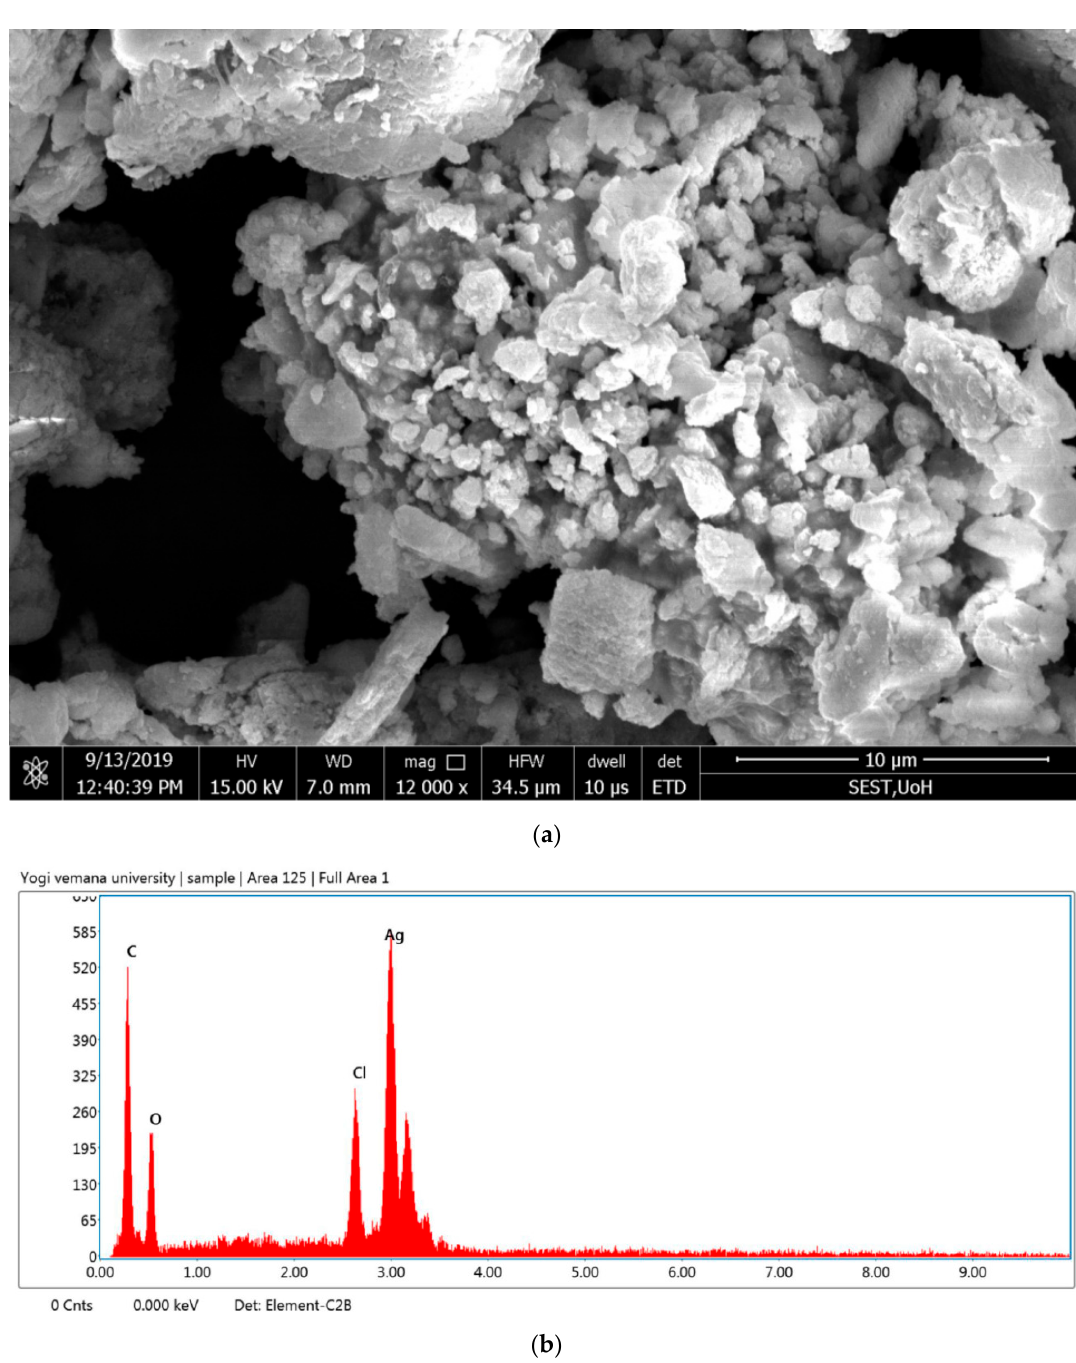
Figure 4. ( a ) Scanning electron microscopy(SEM) images of synthesized Ag NPs from Catharanthus roseus ; ( b ) energy dispersive X-ray (EDX) spectrum of C Ag NPs showing the presence of different phytoelements as capping agents.